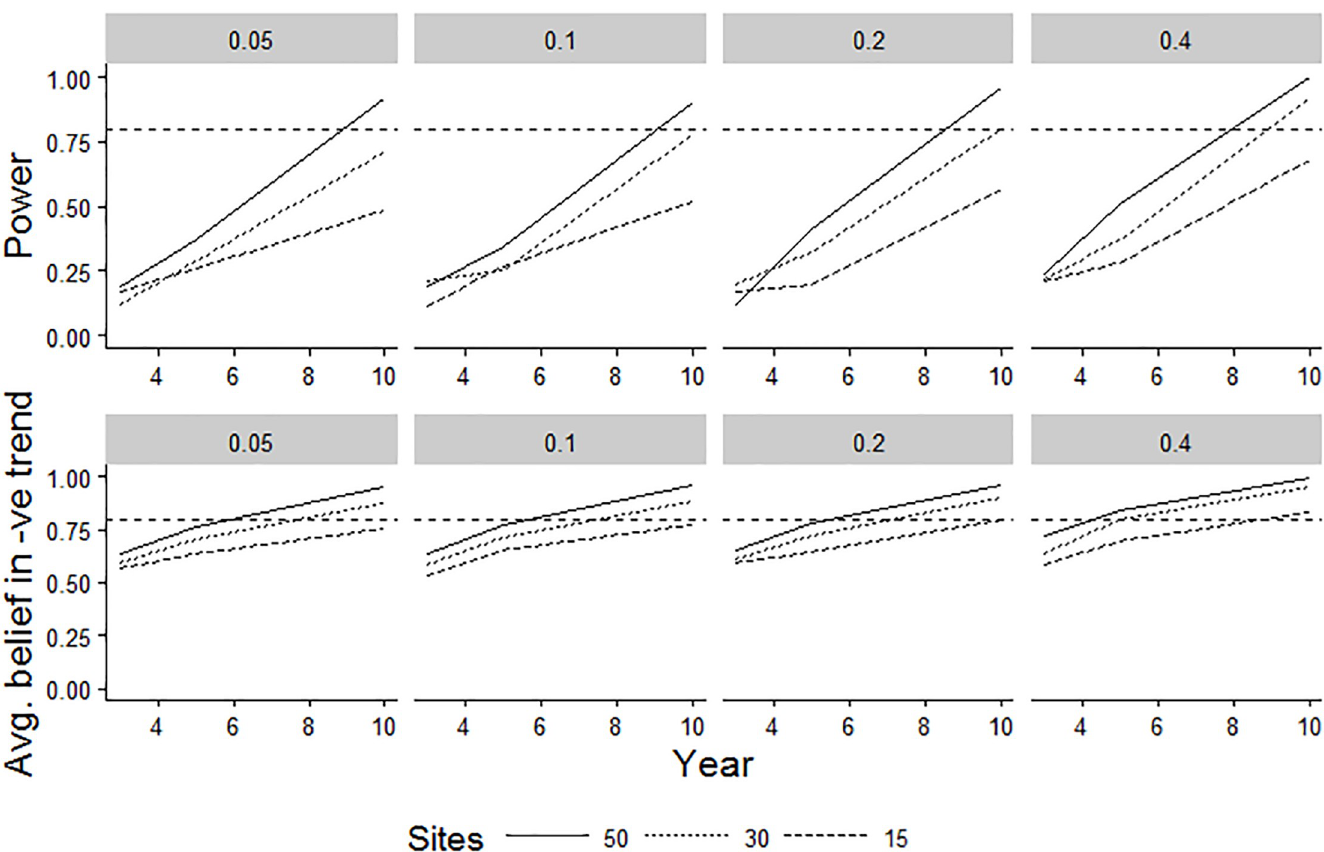
Fig 7. Comparisons of two alternative models of power for a single species’ decline. The underlying simulated decline was 30% per year over 10 years. Different columns represent different starting proportional covers of a species within a plot. The top row represents the results from a classical frequentist power analysis, using maximum likelihood parameter estimates of a simple linear model fitted to interval-censored data (Model 3 of [65]). The bottom row represents the average belief in a declining trend of any size resulting from a Bayesian hierarchical model fitted to interval-censored data. Interval-based data censoring was based on an approximation of the Domin scale in both cases. Trend line formatting relates to the number of modelled sites (n = 15, 30 or 50). The broken horizontal line represents the typically desired level of 80% power; although this is not appropriate for a Bayesian model, it is also included for this model-type to help assist with visual comparisons between the different